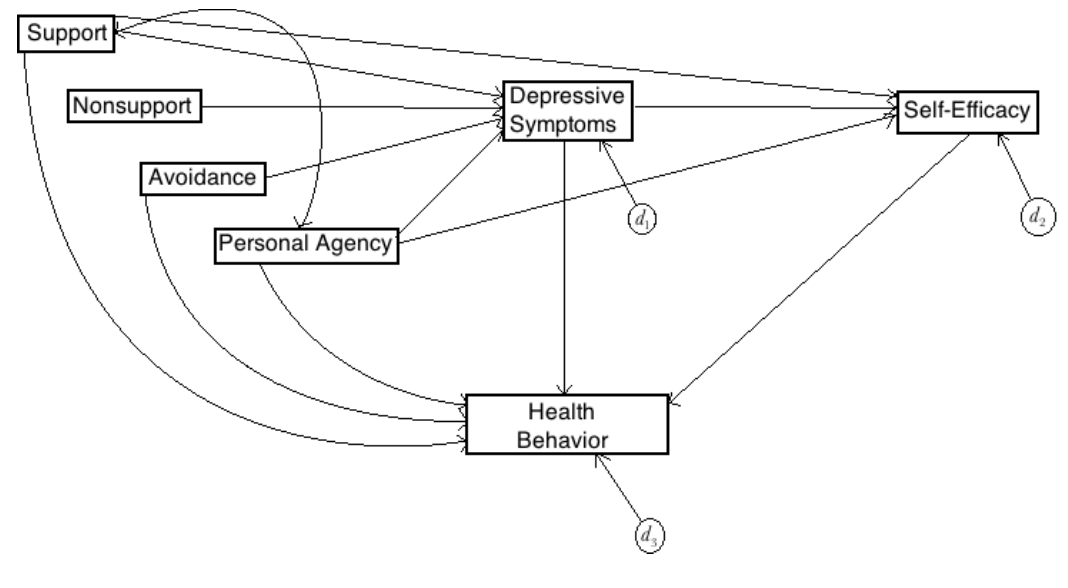
Figure 1. Proposed